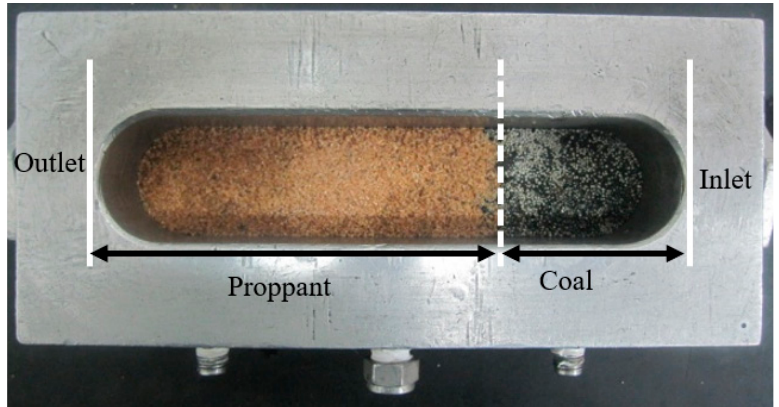
Figure 6. Proppant placement diversion room.